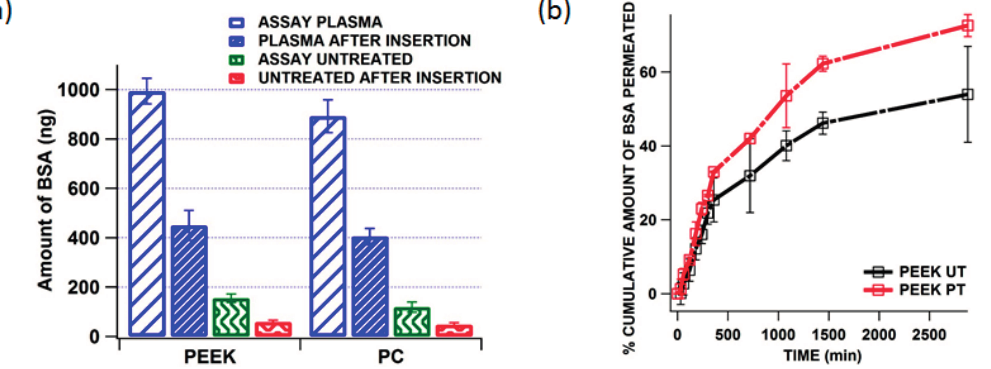
Figure 9. ( a ) Comparison of amount of BSA coated on to the plasma and untreated PEEK and PC microneedles and residual BSA from the needle after insertion; ( b ) comparative permeation profiles of BSA across neonatal porcine skin when released from untreated and plasma treated MN (PEEK). Means (±SD), n ˃